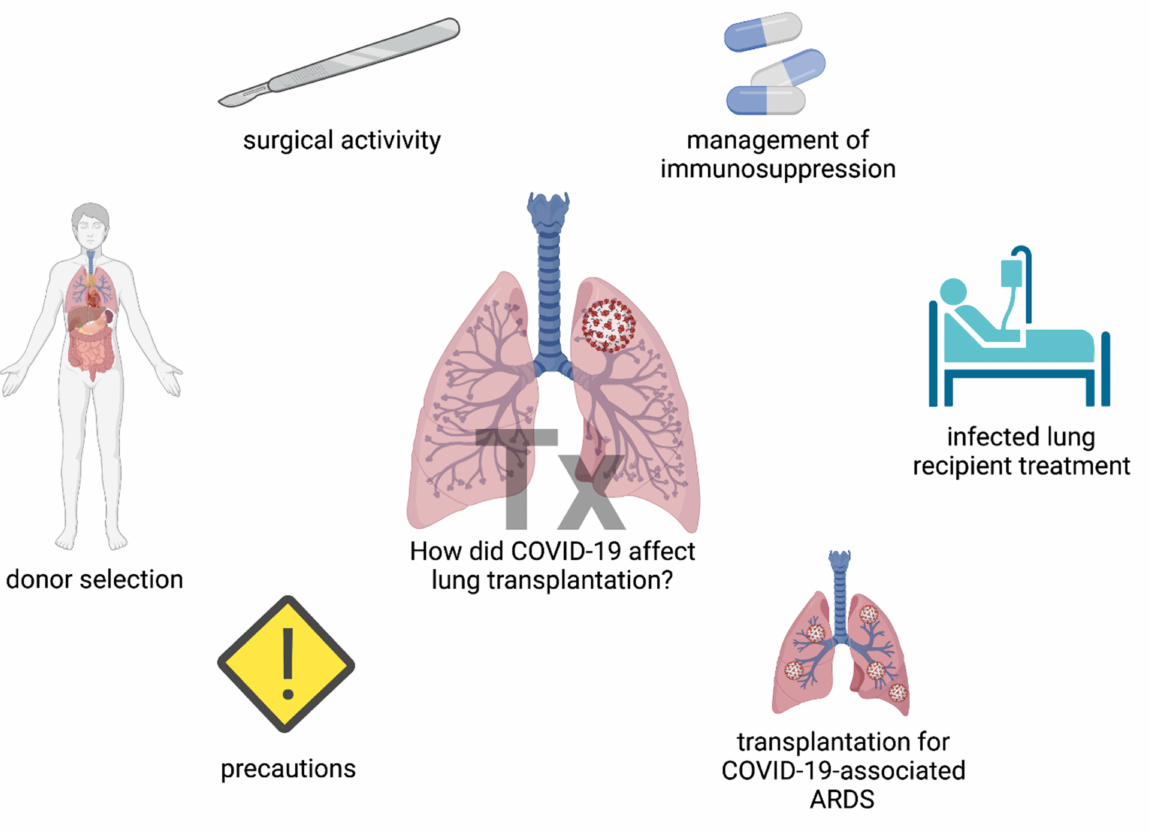
Figure 1. The areas of lung transplantation that were affected by the COVID-19